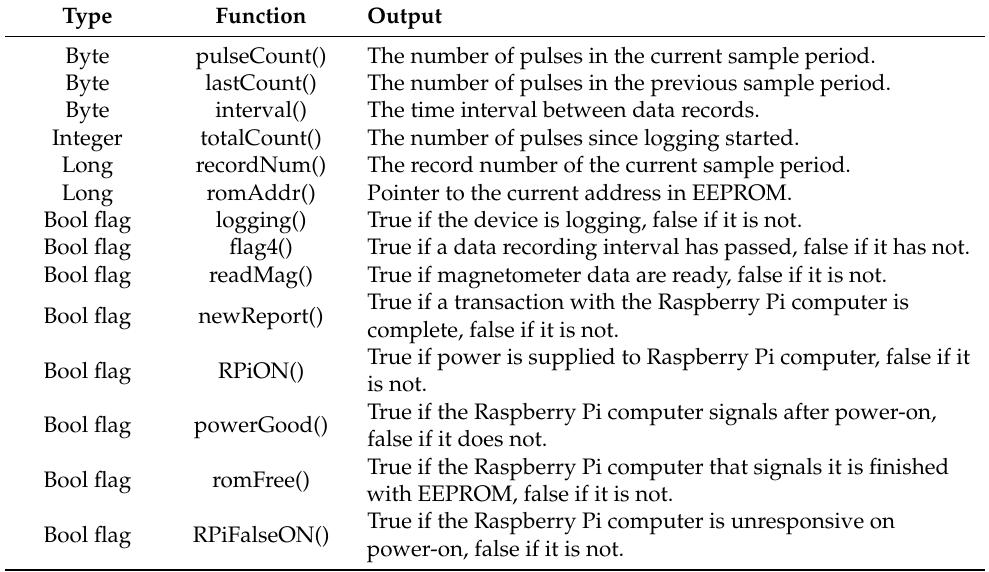
Table 4. System State library